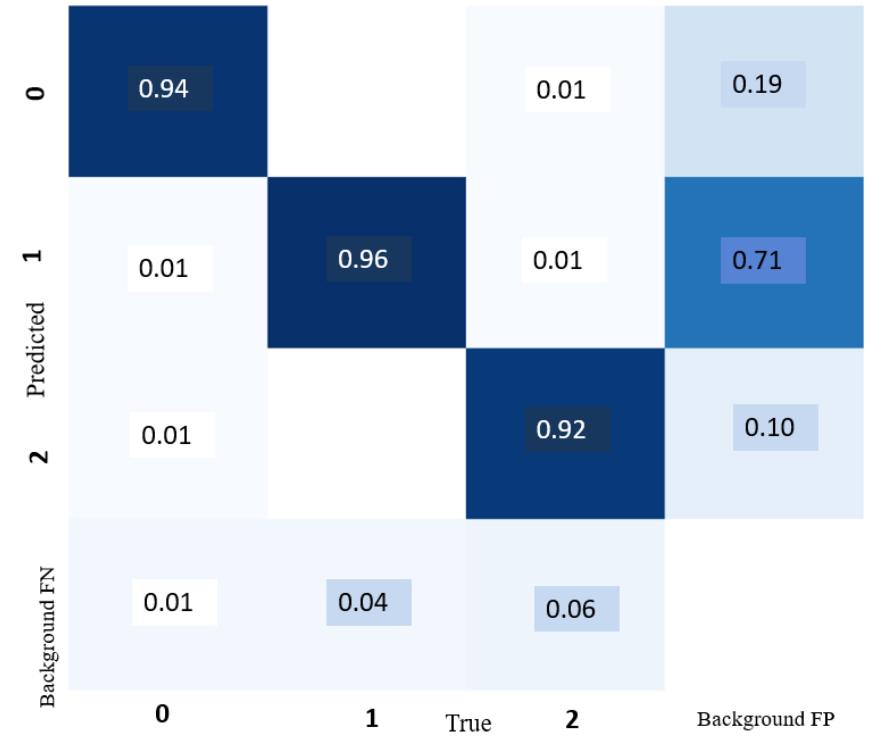
Figure 8. Confusion matrix.